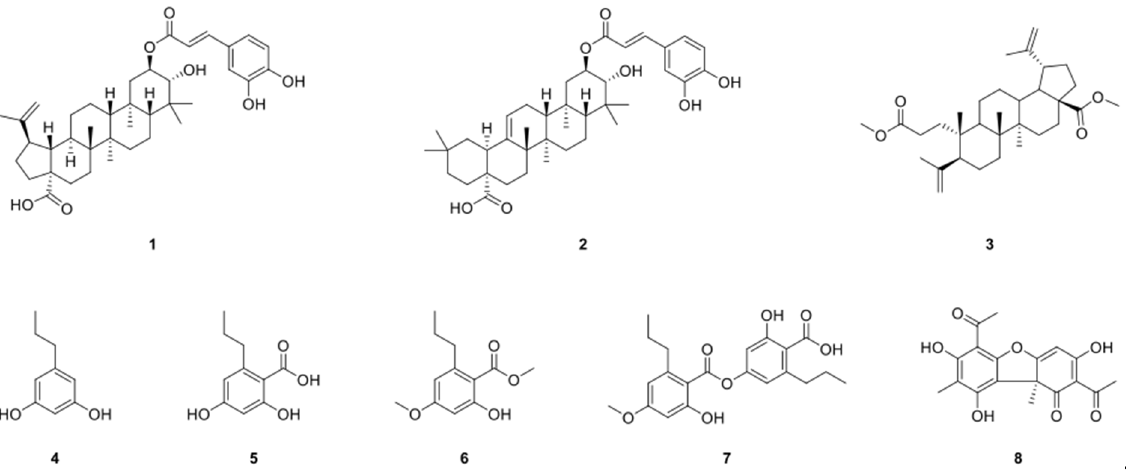
Figure 1. The structures of compounds 1 – 8.